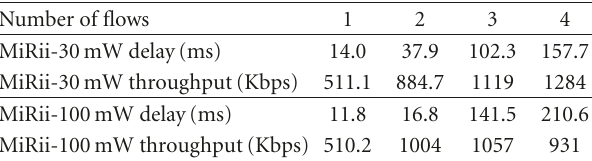
In Figure 5, the light color (red) bars represent the high tra ffi c loading with data rate 1 Mbits/s and the dark color (blue) bars represent the low tra ffi c loading with data